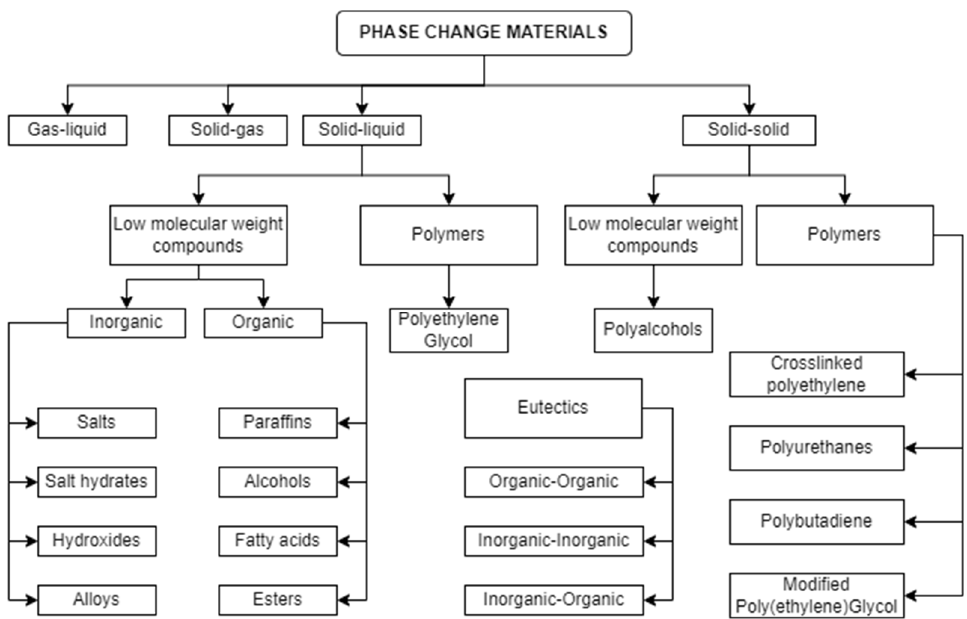
Figure 1. PCMs classification.